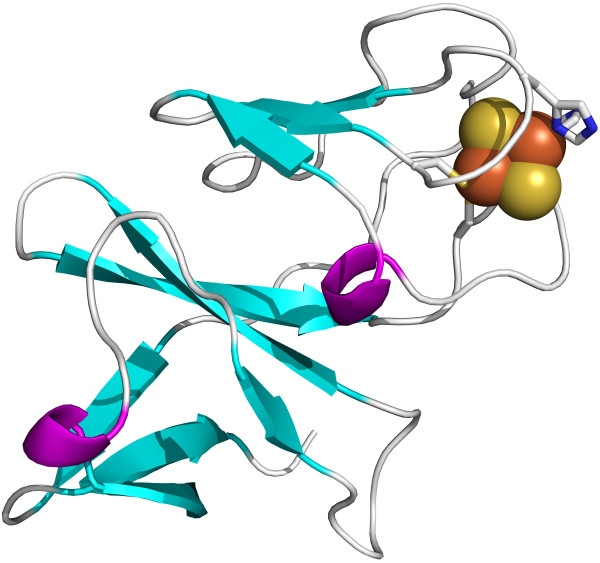
Ribbon diagram of BPDO-FB1 showing the location of the Rieske iron-sulfur cluster. The ribbon diagram shows the conserved Rieske binding domain of the ferredoxin, where the Rieske cluster is positioned near the surface of the protein. The Rieske cluster is shown as spheres, where iron is orange and sulfur is yellow. The residues that directly interact with the Rieske cluster are shown as sticks. Beta sheets are shown in blue and alpha helices are shown in purple.